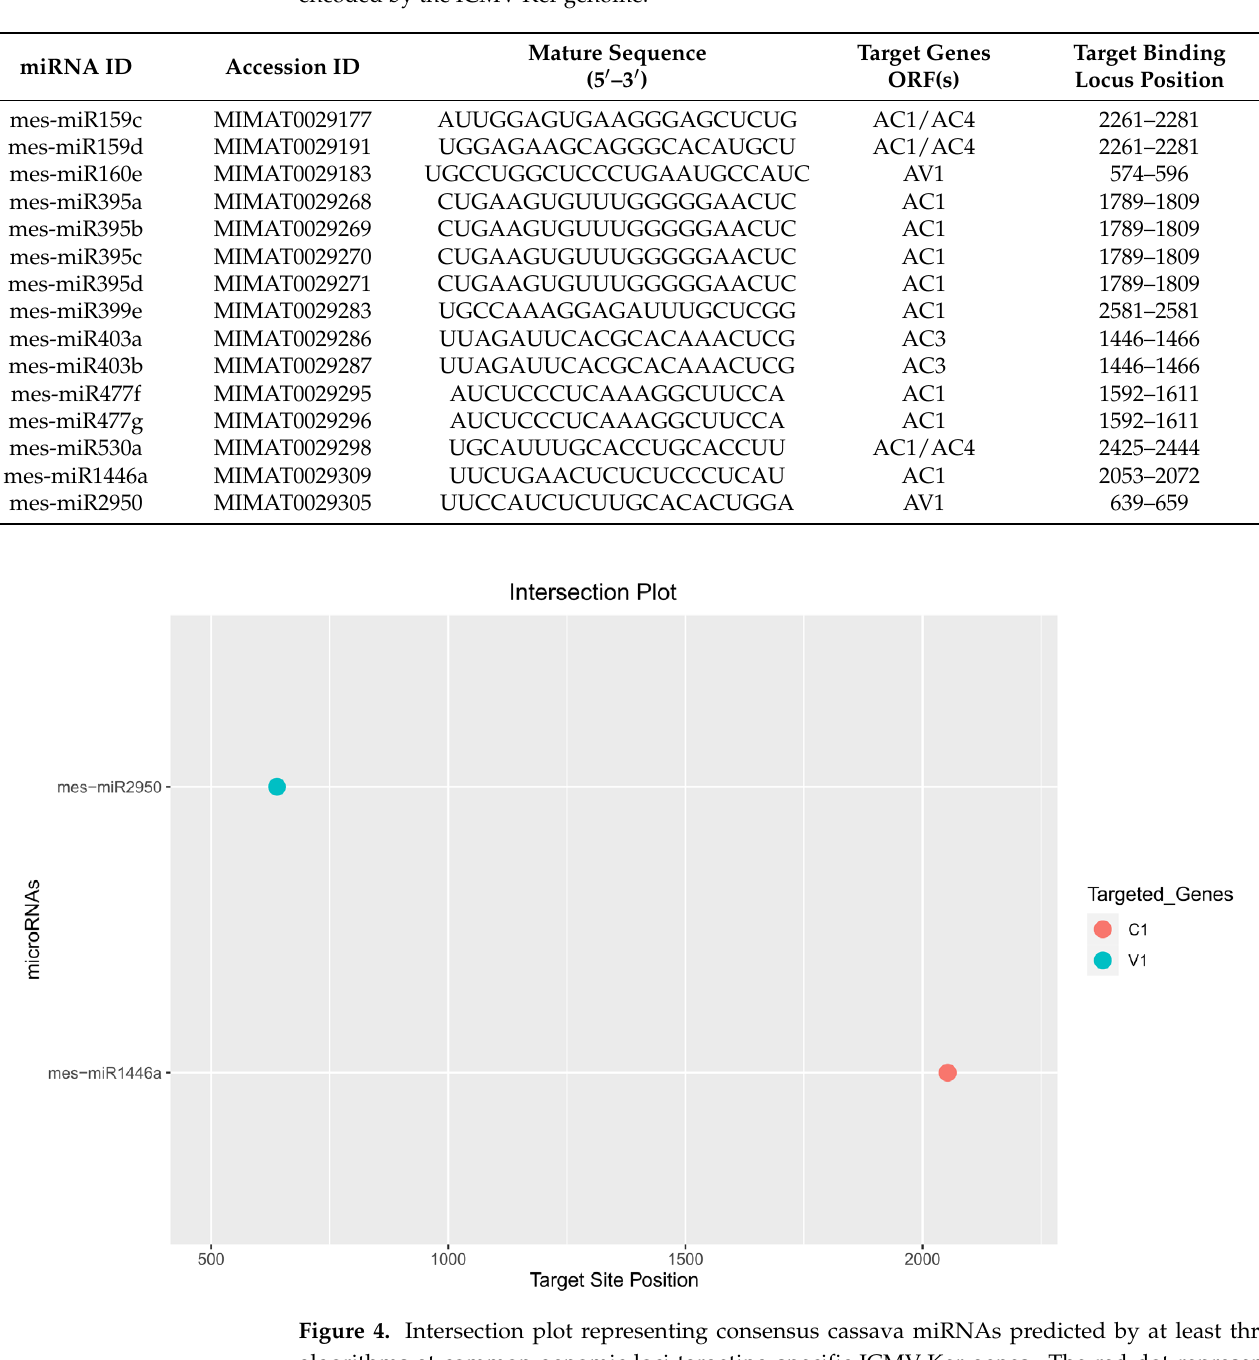
Table 4. Predicted consensus cassava locus-derived mes-miRNA binding sites targeting genes encoded by the ICMV-Ker genome.